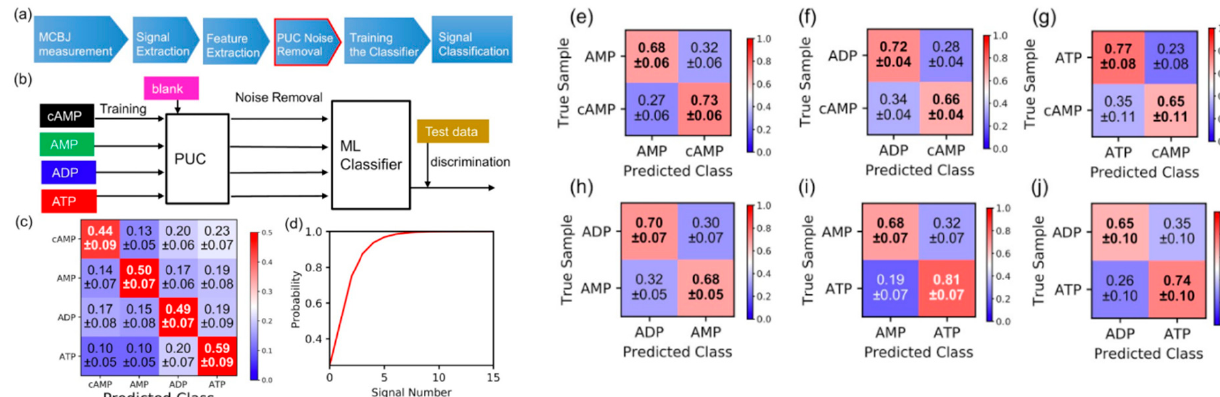
Figure 5. ( a ) Flow of data acquisition and analysis with positive and unlabeled data classification (PUC) method. In the PUC method, the signals obtained from the blank solution (control experiments) were used as positive signals. On the other hand, the signal data of the sample solution were regarded as unlabeled data because these signals were composed of both blank signals and the sample molecule signals. ( b ) Schematic of machine learning analysis using PUC method. ( c ) Evaluation results for discrimination accuracies of cAMP, ADP, AMP, and ATP using the PUC method. Compared to the discrimination accuracy value of 0.25 for cAMP without the PUC method, the average discrimination accuracy was also improved to 0.50. The classifier was trained with 1000 signals. ( d ) Relation between probability of accurate prediction by majority vote and number of signals. The accuracy was set to 0.5 for four classes. ( e – j ) Evaluation of discrimination accuracy of cAMP from other molecules, i.e., AMP, ATP, and ADP. The two-target discrimination accuracy values were found to be 0.70 for AMP/cAMP ( e ), 0.69 for ADP/cAMP ( f ), 0.75 for ATP/cAMP ( g ), 0.69 for AMP/ATP ( h ), 0.74 for ATP/AMP ( i ), and 0.69 for ADP/ATP ( j ) .